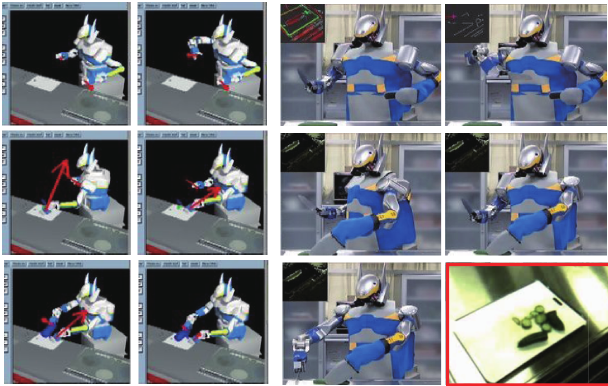
Figure 8. Cutting vegetable with a knife and its